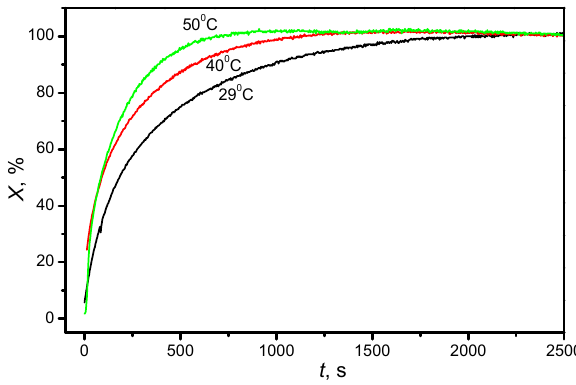
Figure 7. Kinetic curves of LiFePO 4 /C chemical delithiation process at different temperatures.